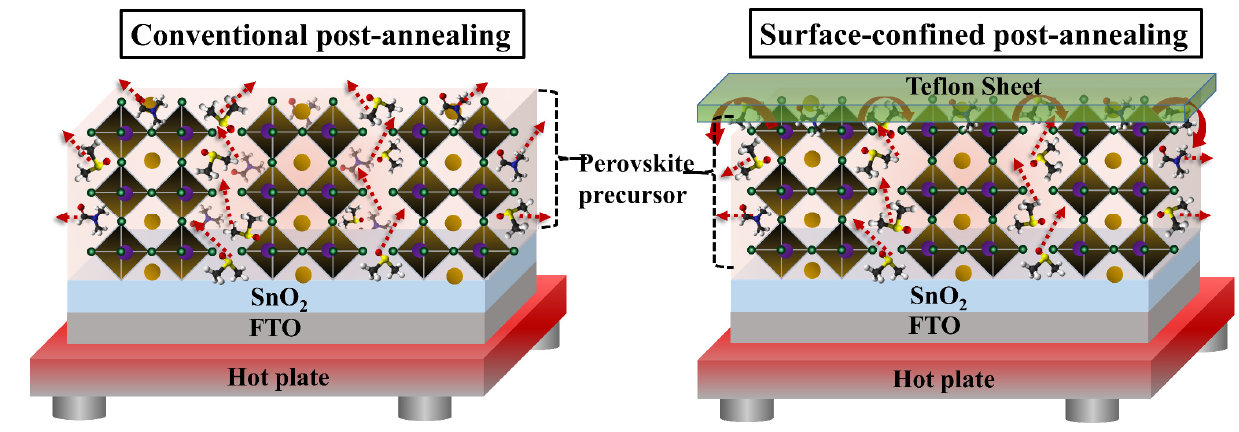
Figure 1. Schematic illustration of conventional post-annealing (CPA) and surface-confined post- annealing (SCPA) proposed for the preparation of perovskite thin-films.